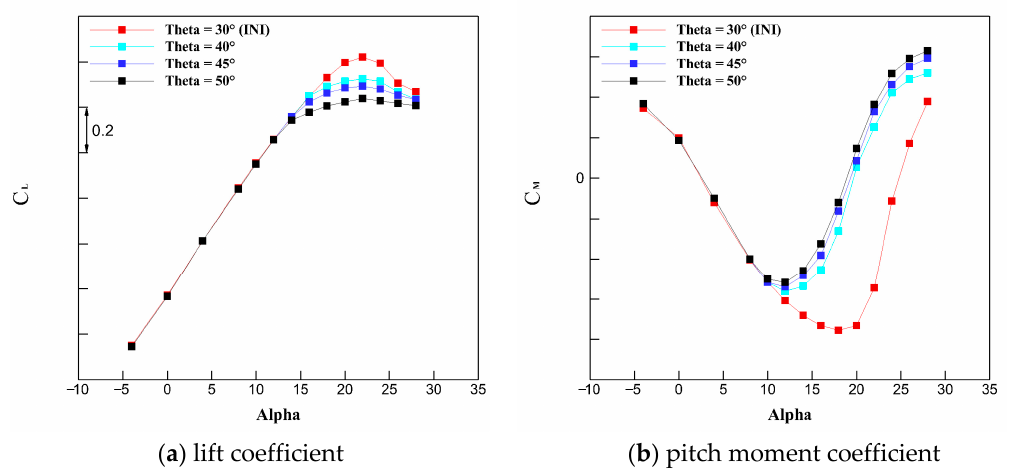
Figure 15. Aerodynamic coefficient of the sensitivity analysis of Theta.